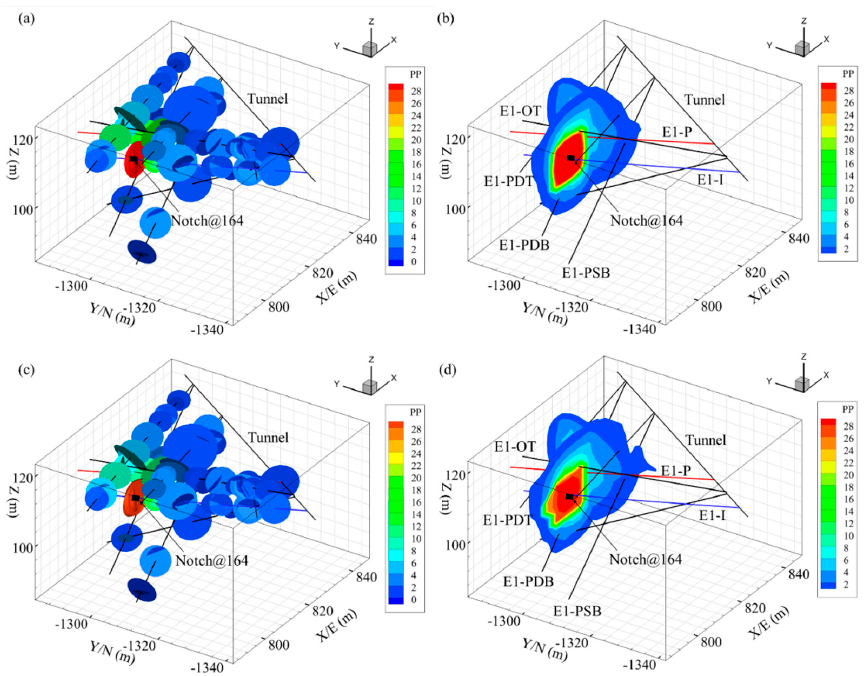
Figure 12. The results from numerical simulation: ( a , b ) show the fractures and matrix pressure at T22:44; ( c , d ) show the fractures and matrix pressure at T22:45. Unit: MPa.